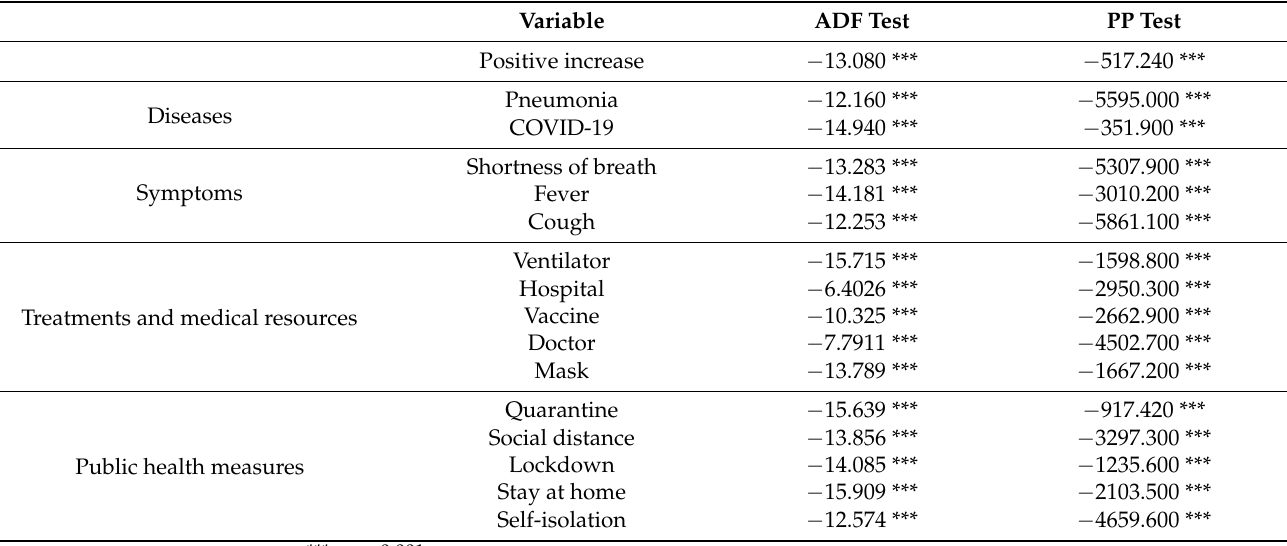
Table 2. Unit root test results for 15 variables.